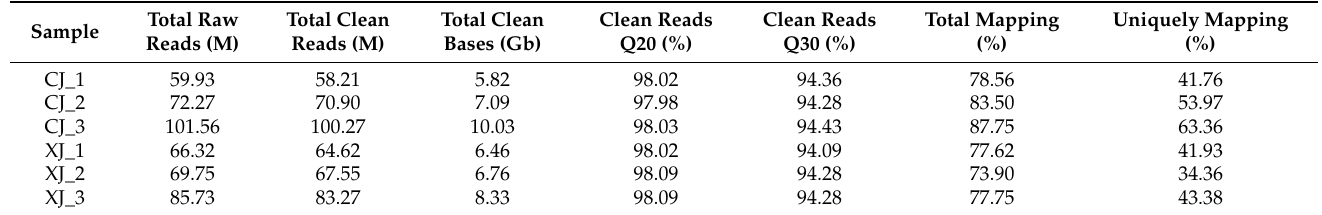
Table 1. Sequencing and mapping statistics of blood samples for the Yangtze finless